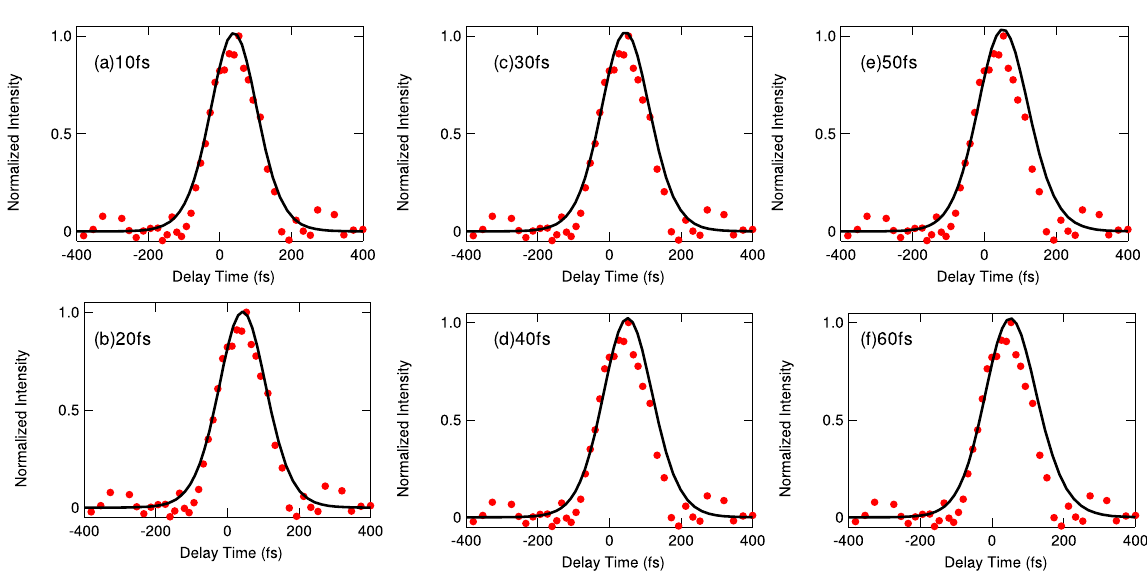
Figure 6. Parameter dependence of the fitting with the observed delay-time dependence of the TG signal at 300 K, which is the same as that in Fig. 3(f). The decay times from 10 fs to 60 fs are